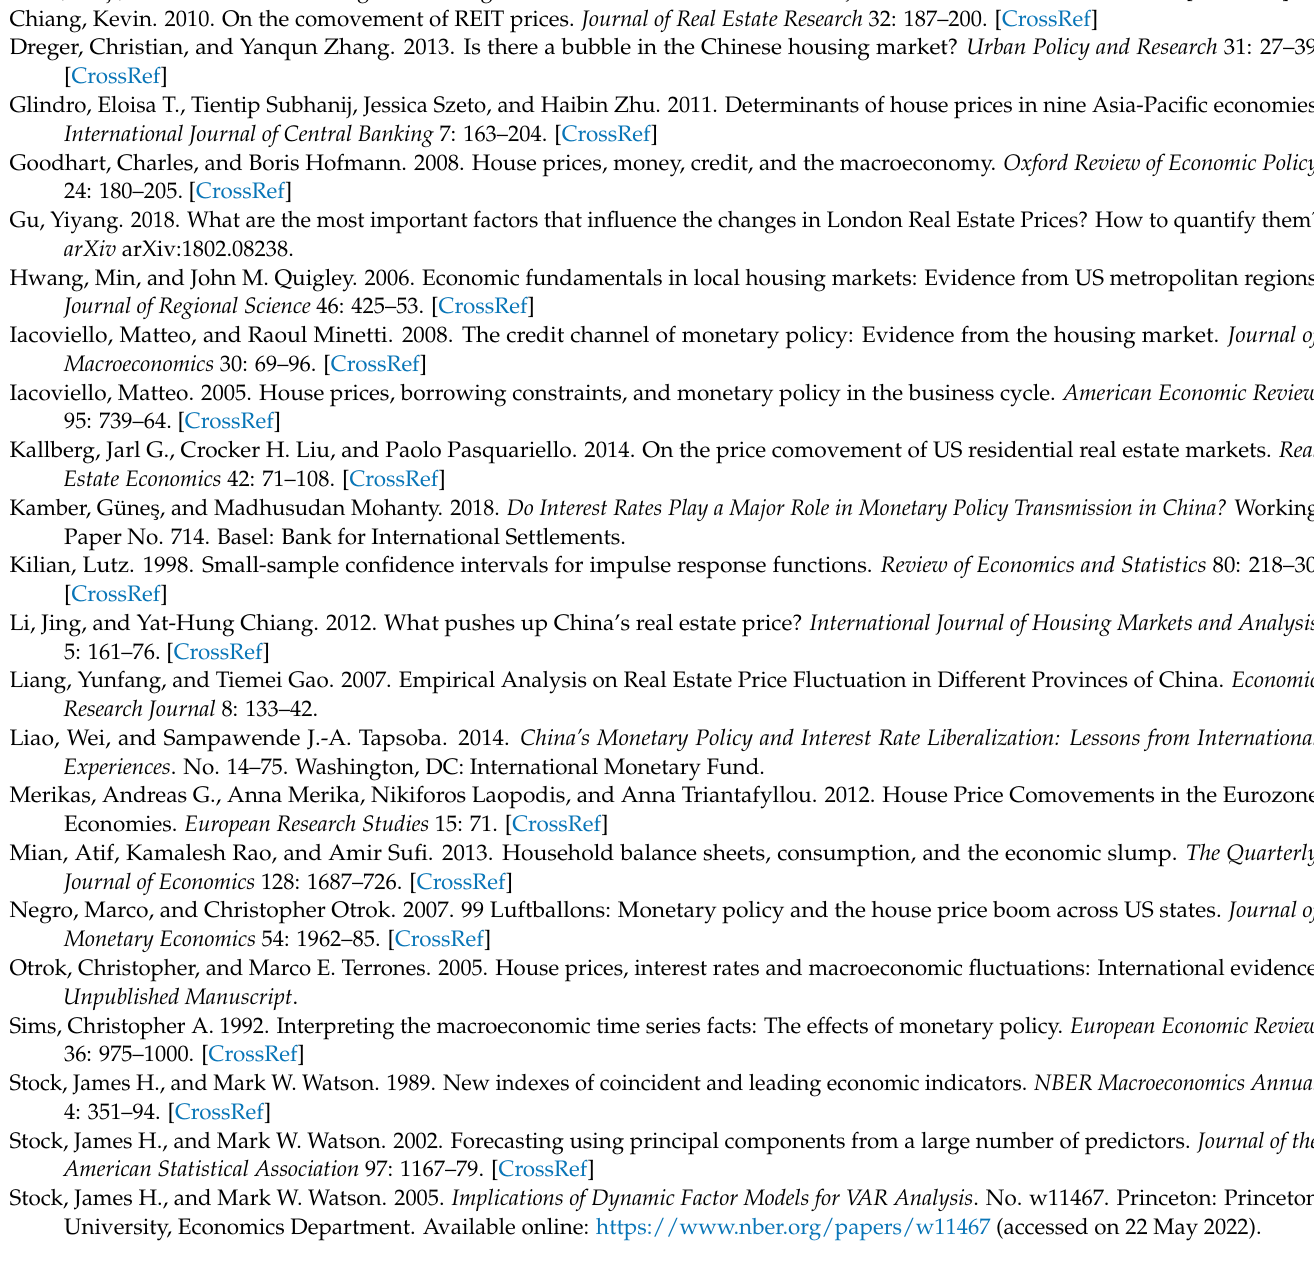
The Regional Coordinative Development Strategy is formulated on the Third Plenary Session of the 16th CPC Central Committee. It refers to actively promoting the development of the western region, revitalizing the old industrial bases such as the northeast region, promoting the rise of the central region, encouraging the eastern region to take the lead in development, continuing to give full play to the advantages and enthusiasm of each region, and gradually reversing the trend of widening the regional development gap by improving market mechanisms, cooperation mechanisms, mutual aid mechanisms, and support mechanisms so as to form a mutual promotion, complementary advantages, and a common ground between the east and the west. This is a new pattern of